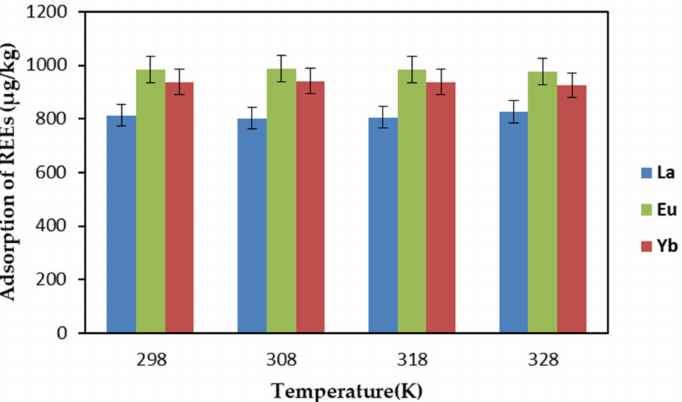
Figure 5. Effect of temperature on REEs adsorption of REEs by EDTA–CS@ZIF-8.